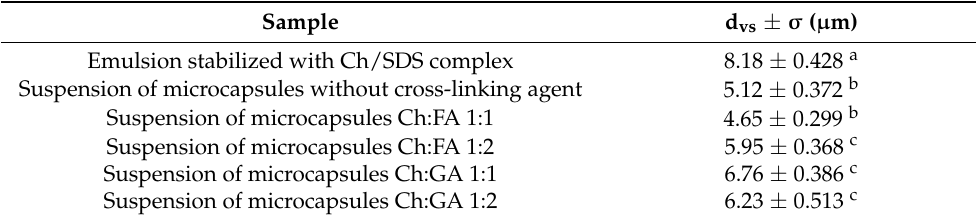
Table 3. Particle size distribution parameters of the emulsion and microcapsules suspensions in water: d vs —Mean diameter; σ —Standard deviation. Different superscript letters (within one column) represent significant differences ( p < 0.05), as obtained by ANOVA and Tukey’s HSD test.